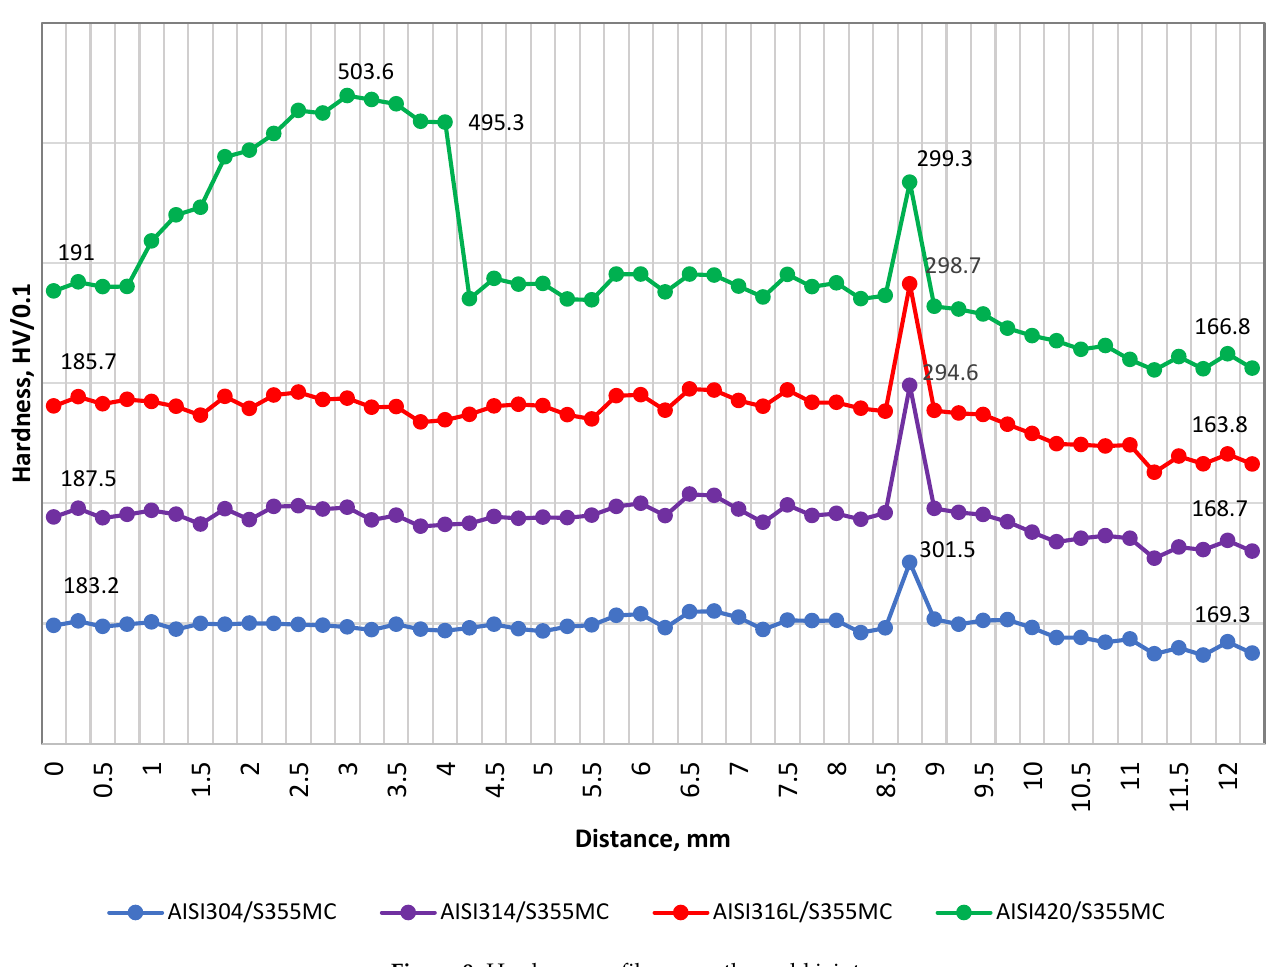
Figure 9. Hardness profile across the weld joints.